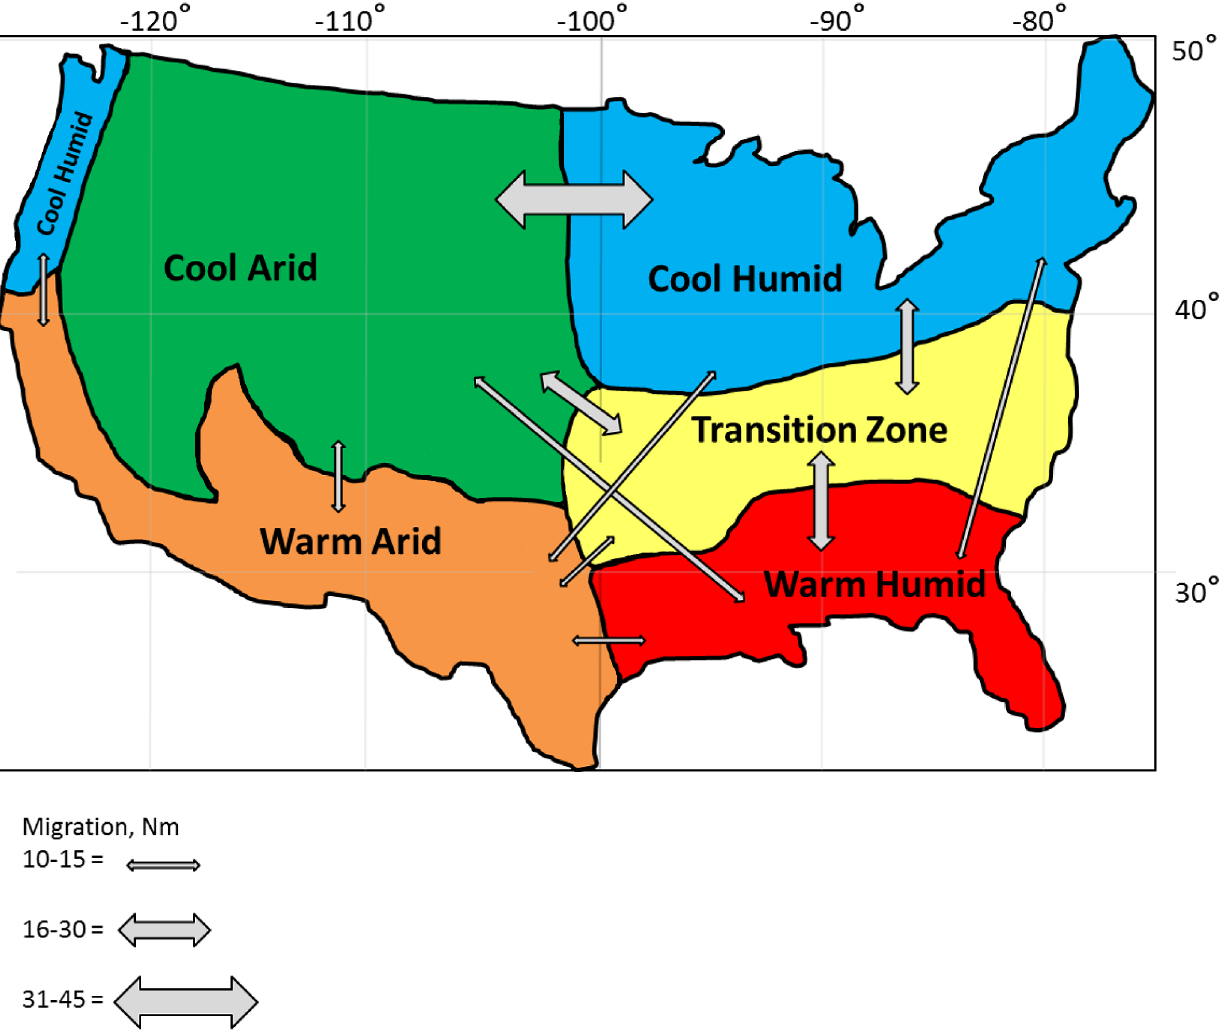
Fig 1. Ecoregions for the United States and the relative magnitude of gene flow (number of animals migrating between ecoregions per generation) among the ecoregions as indicated by the thickness of the arrows.